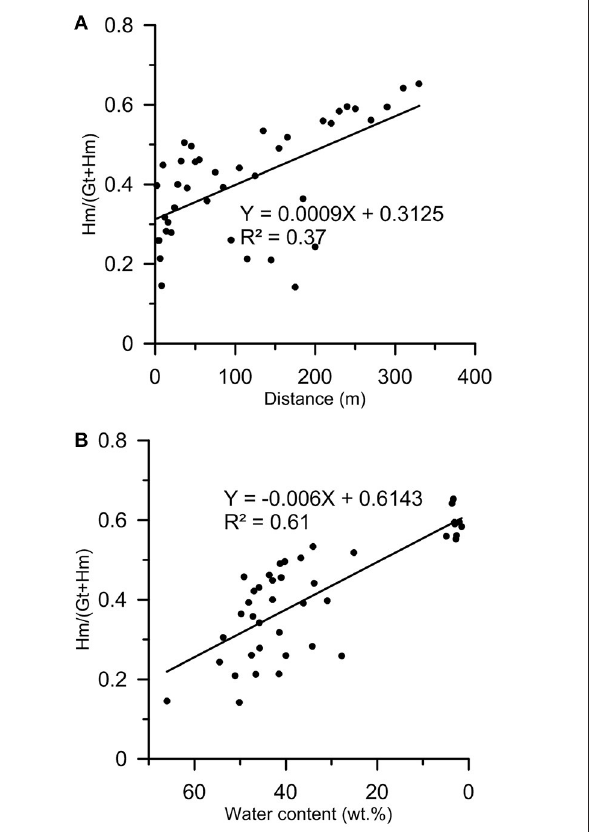
FIGURE 9 | Scatter plots of (A) the distance from the lake edge vs. Hm/(Gt + Hm), and (B) water content vs. Hm/(Gt + Hm). most of the wet grassland samples within 0.2–1 µ m ( Figure 8B